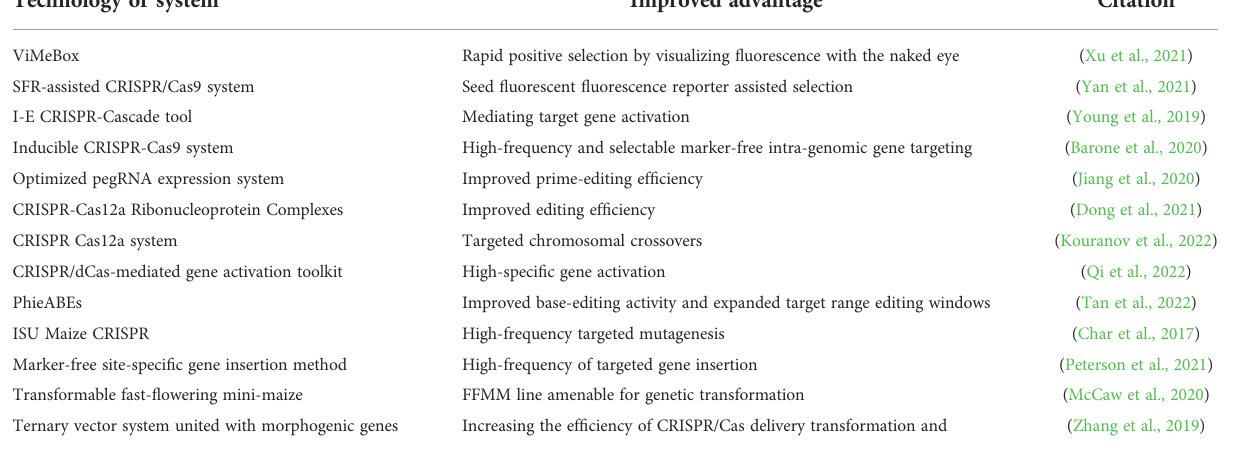
TABLE 2 Improved gene editing technologies and transformation methods in